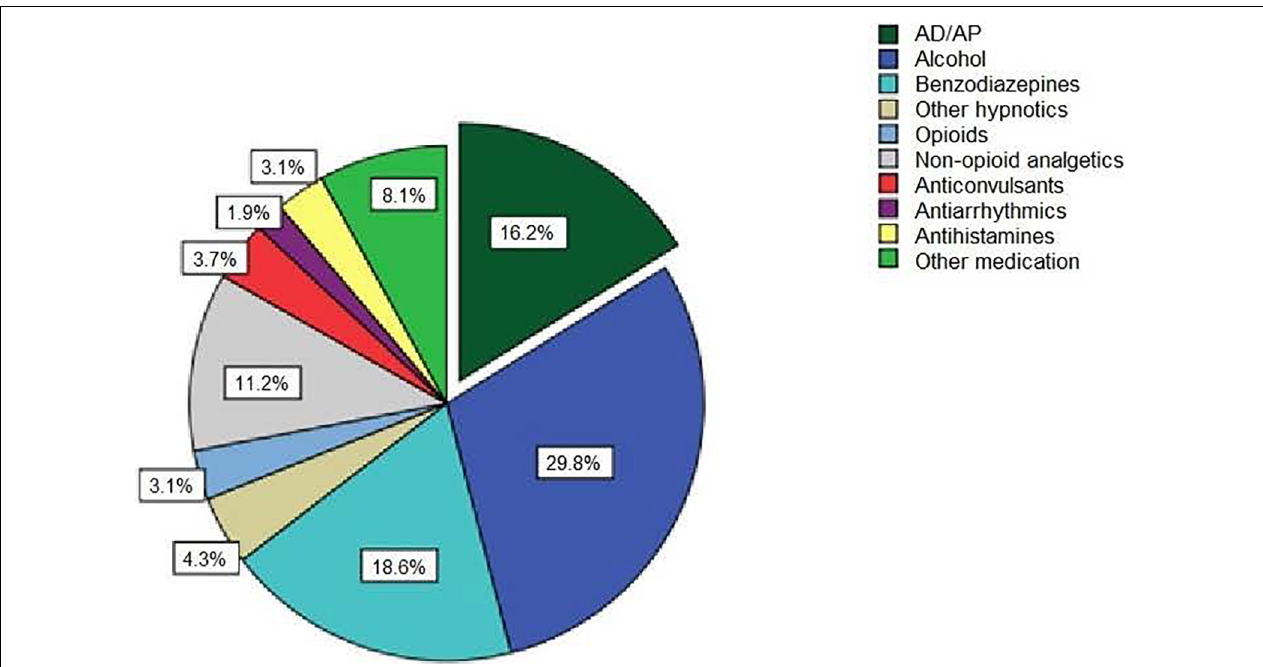
FIGURE 2 | Categories and shares of all substances utilized for overdosing. (AD/AP =